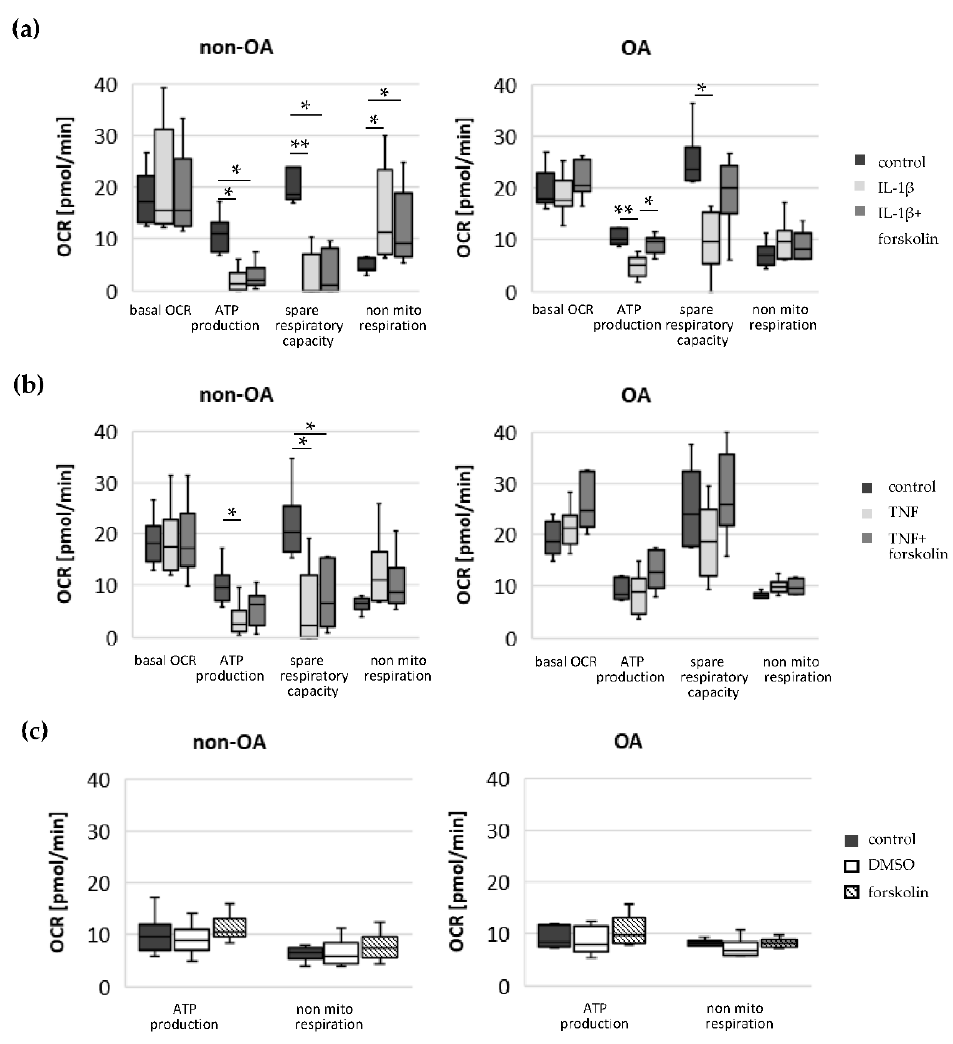
Figure 3. Changes in basal oxygen consumption rate, mitochondrial ATP production, spare respiratory capacity and non-mitochondrial respiration of non-OA and OA chondrocytes before and after stimulation with ( a ) IL-1 β and forskolin (non-OA patients = 6, OA patients = 7), ( b ) TNF and forskolin (non-OA patients = 6, OA patients = 6) and ( c ) forskolin and DMSO (non-OA patients = 6, OA patients = 6). Values are displayed as box plots. Statistics: Kruskal–Wallis test followed by Mann–Whitney U test and Bonferroni correction. ** p < 0.01 and * p < 0.05. Control: unstimulated cells; DMSO: dimethyl sulfoxide; OCR: oxygen consumption rate; mito: mitochondrial.